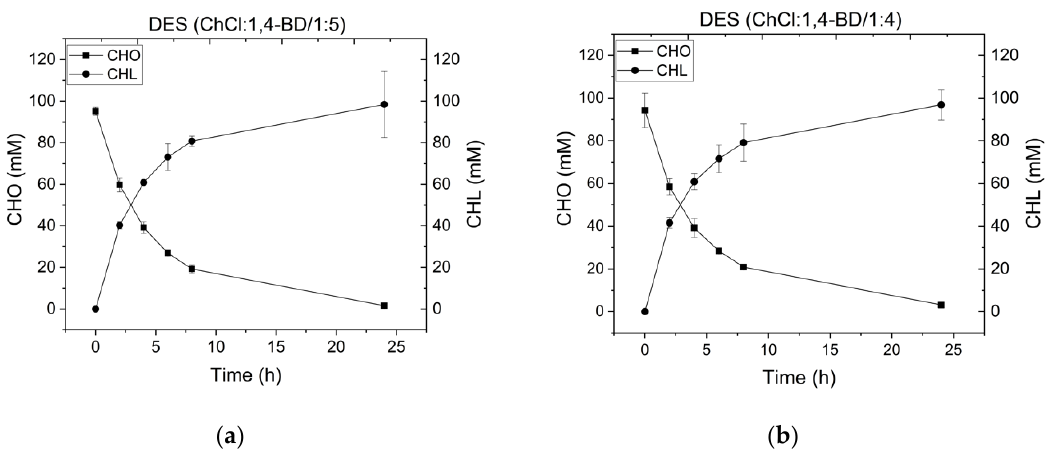
Figure 1. HLADH-catalyzed CHO reduction in two different mixtures of DES-buffer (80:20, v/v ): ( b ) DES (ChCl:1,4-BD/1:4); ( a ) DES (ChCl:1,4-BD/1:5). Reaction conditions: 100 mM CHO, 1 mM NAD + , 1 mg/mL purified HLADH. 25 °C, and 1200 rpm.